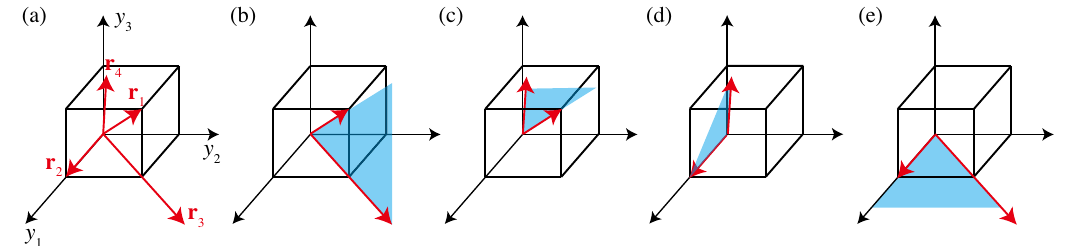
FIG. 7. The rays and boundary planes in the polyhedral cone X in SG 150. (a) r 1 ¼ ð 1 ; 1 ; 1 Þ T , r 2 ¼ ð 1 ; 0 ; 0 Þ T , r 3 ¼ ð 2 ; 2 ; 0 Þ T ,